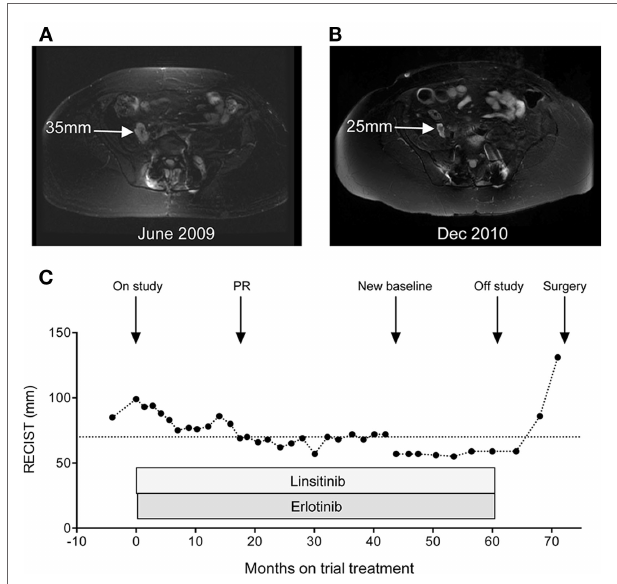
FIGURe 2 | objective response of chordoma to linsitinib and erlotinib . (a) Baseline MRI pelvis in June 2009, showing right iliopsoas deposit. Additional marker lesions were measured in the oblique right psoas (29 mm) and left paravertebral region (35 mm) giving a sum for the three lesions of 99 mm. (B) Response MRI of December 2010 showing reduction in size of right iliopsoas deposit. (C) Graph: monitoring of serial MRI scans by RECIST criteria, represented as the sum of measurements of the three marker lesions described in (a) . After 44 months (February 2013), these three lesions were no longer clearly measurable, and a new marker lesion (left external iliac, 57 mm) was selected to monitor response to linsitinib dose escalation from 50 mg QD to BID.